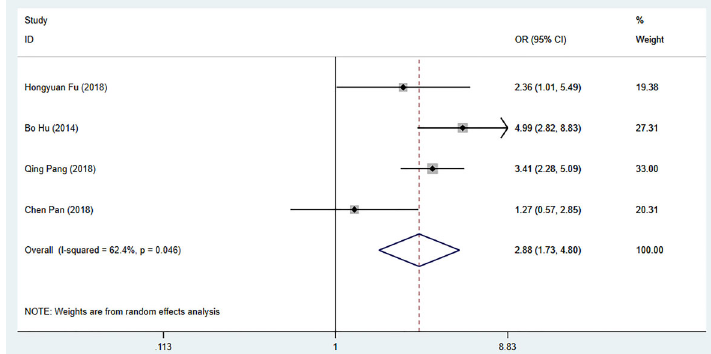
Figure 6. Forest plot of the relationship between preoperative systemic immune-in fl ammation index and tumor diameter. See Supplementary Table S2 for reference numbers.